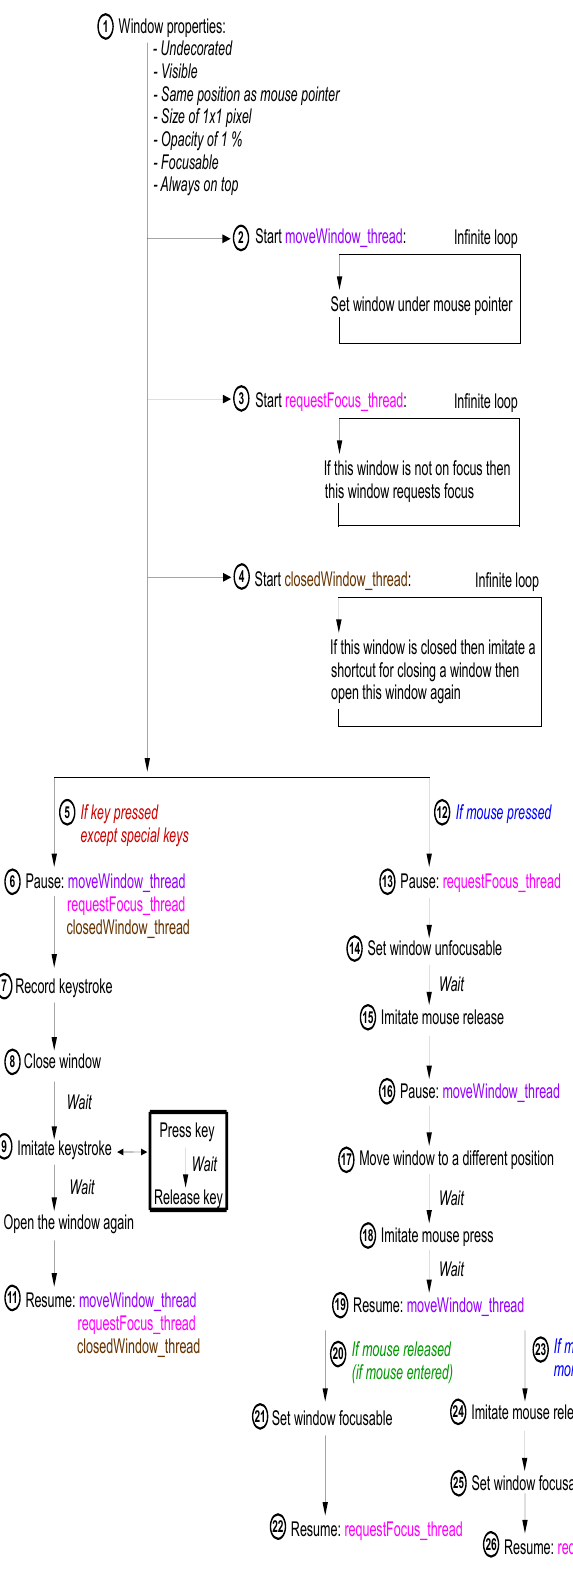
Figure 3. Implementation of Mouse